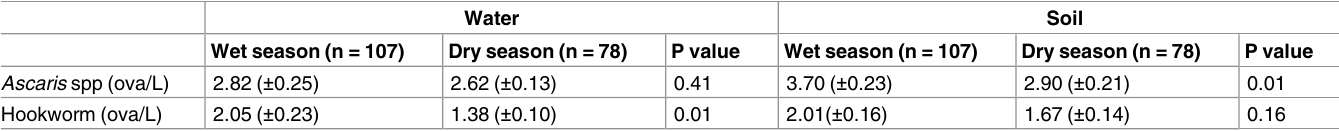
Table 1. Mean concentration ( ± S.D)of Ascaris spp and hookworm ova in irrigation water and soil for the dry and wet season in Kumasi, Ghana. Water Wet season (n =